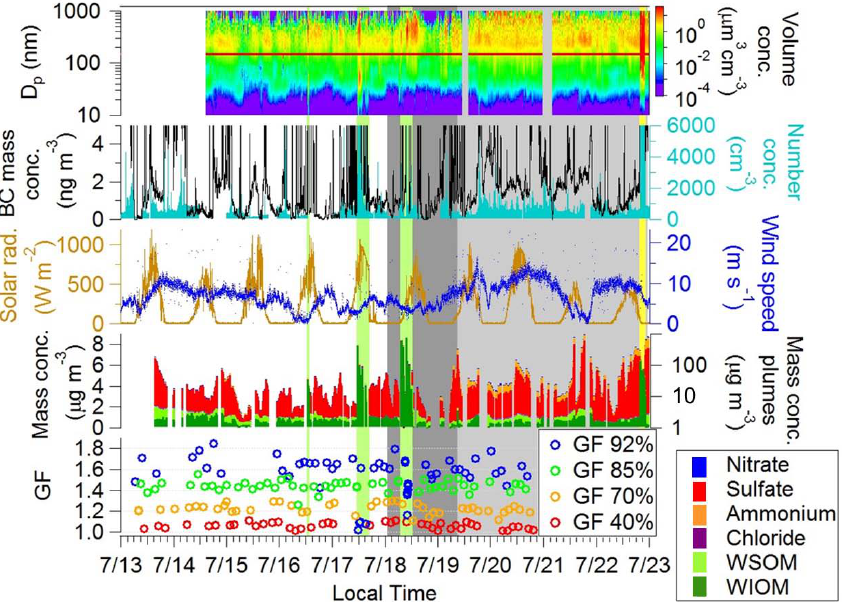
Fig. 3. Submicrometer volume distributions (SEMS), total number concentrations <6000cm − 3 (CPC), black carbon concentrations <5 ngm − 3 (SP2), chemical composition (AMS and PILS), and hygroscopic growth factors (HTDMA) for a dry particle size of 150nm (indicated in the volume distribution (top panel) by the red line) and four different RHs as a function of time over the entire research cruise. Green shading: plume; yellow shading: ship stack exhaust; no shading: Regime 1; dark-gray shading: Transition; light-gray shading: Regime 2. Mass concentrations for AMS and PILS in green or yellow shading (plumes) pertain to the right y axis. Refer to Sect. 3.1 for more details.